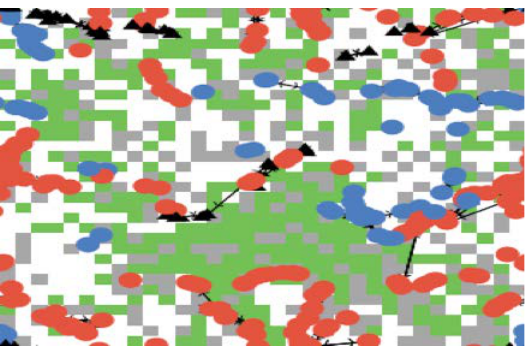
Figure 4. The model is paused at tick 15. A